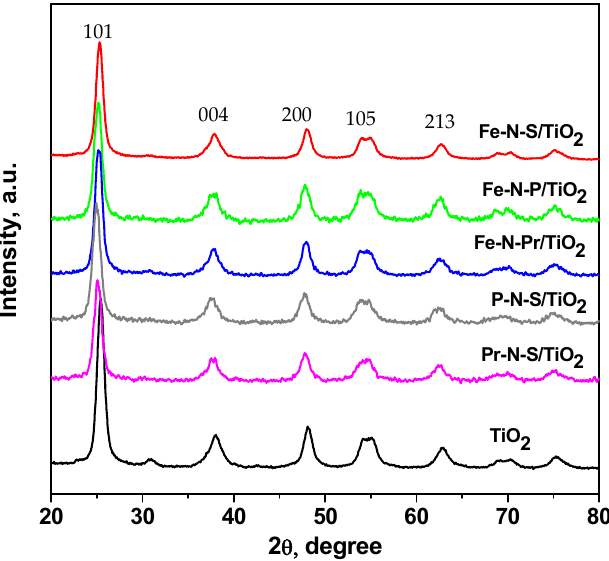
Figure 2. XRD patterns of all prepared samples.